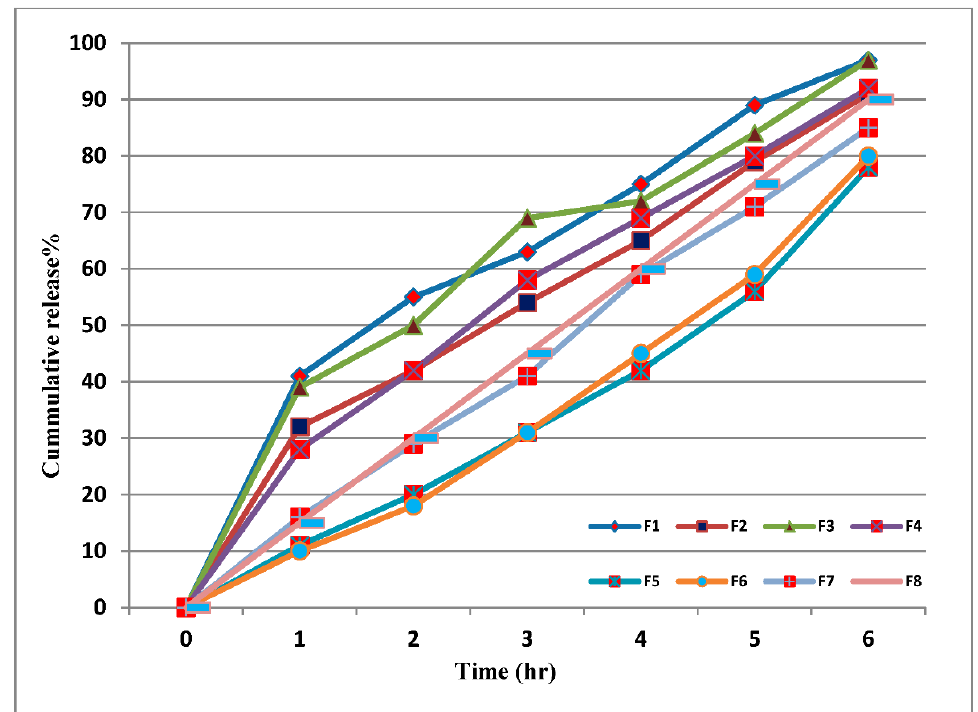
Figure 4. LC release profile from prepared LC-loaded CS nanoparticles (F1 to F8).